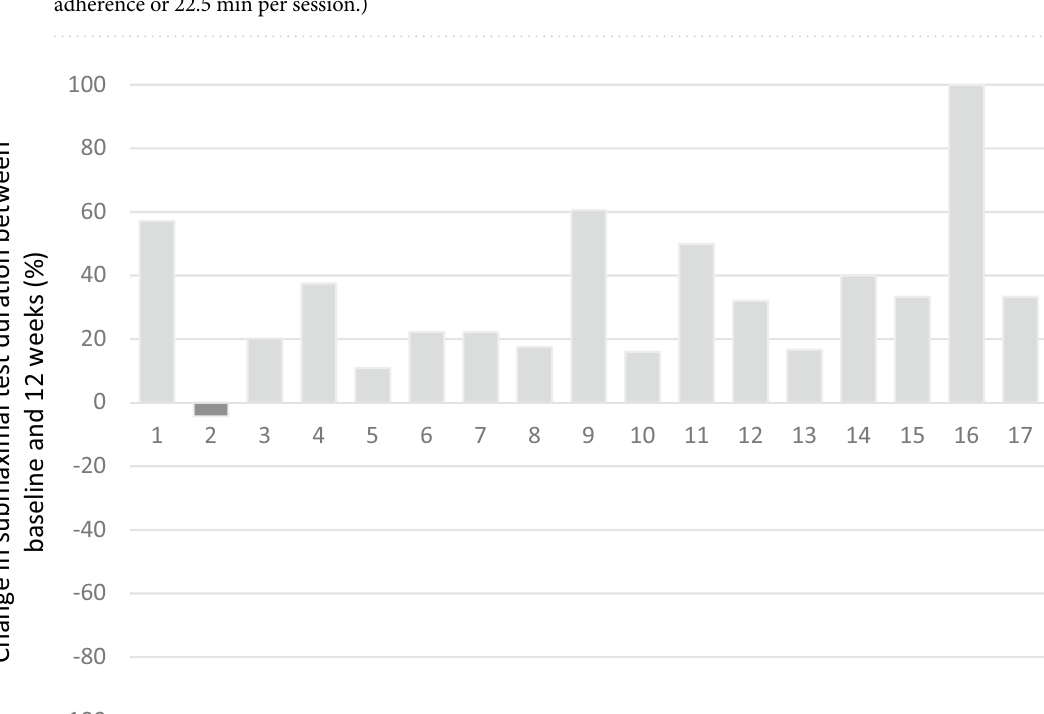
Figure 4. Percentage change in submaximal test duration between baseline and 12 weeks for 17